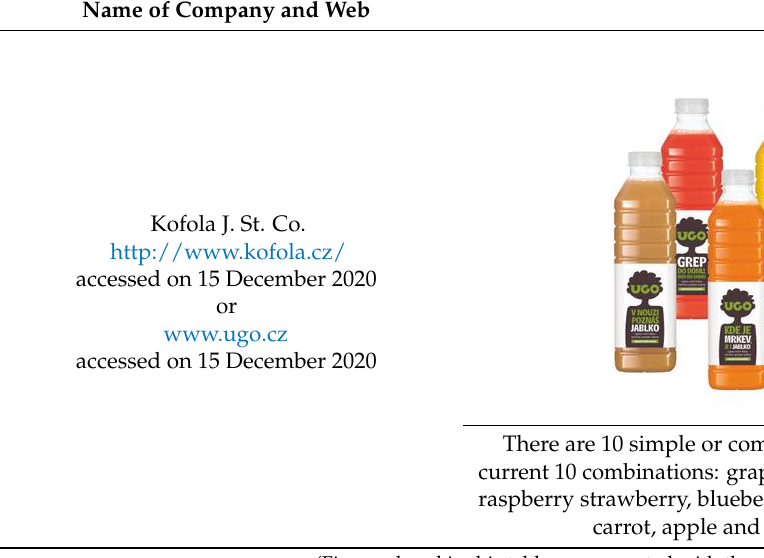
Table A9. High pressure treated products by the company Kofola or UGO.